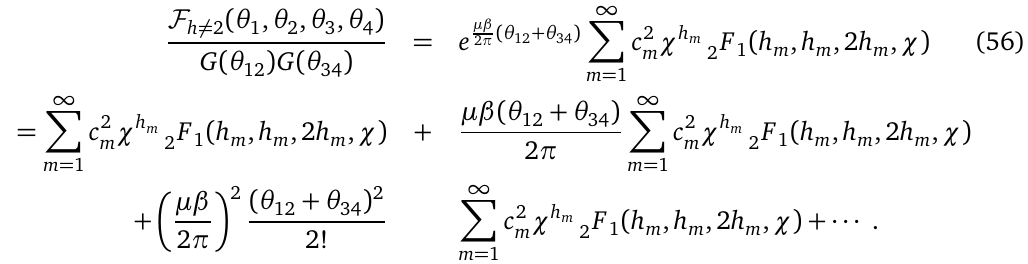
Figure 2: The plot of the six point function S in the short time limit θ figure we have chosen arguments θ